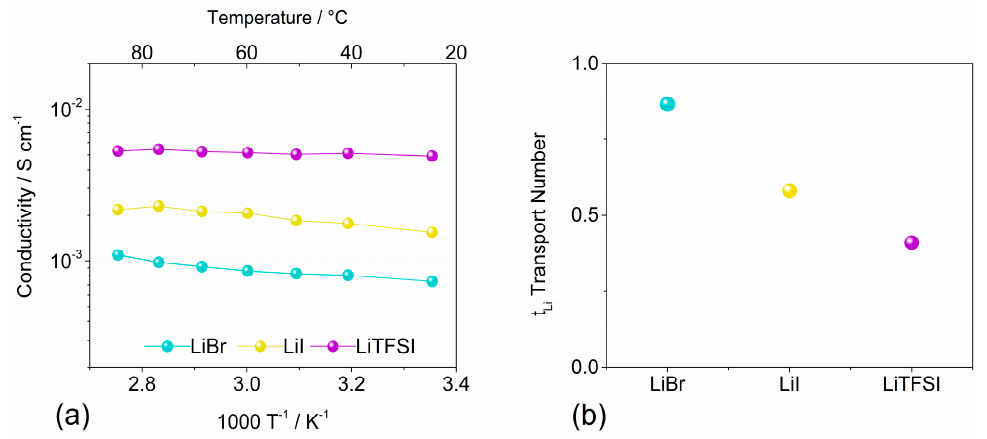
Figure 3. ( a ) Comparison of conductivity Arrhenius plots upon heating obtained by EIS measurements and ( b ) lithium transport number of LiBr, LiI, and LiTFSI electrolytes obtained by the Bruce–Vincent method in a symmetrical Li/Li T − cell at room temperature.